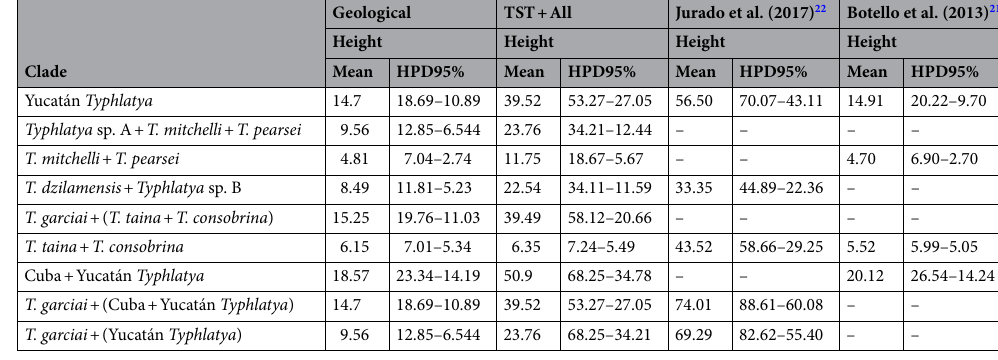
Table 1. Comparison of mcraAges of Yucatán and Cuba clades estimated in previous work 21,22 to those of the current study, resulting from BEAST2 analyses. Results are based on the relaxed, log-normal clock model with five gene partitions and five independent clocks with four geological events (Geological) 21 and/or a secondary fossil calibration-based node age for the TST complex (TST+All with Geological) as calibration points 22 . See also STables 5 and 6 for complete results of all